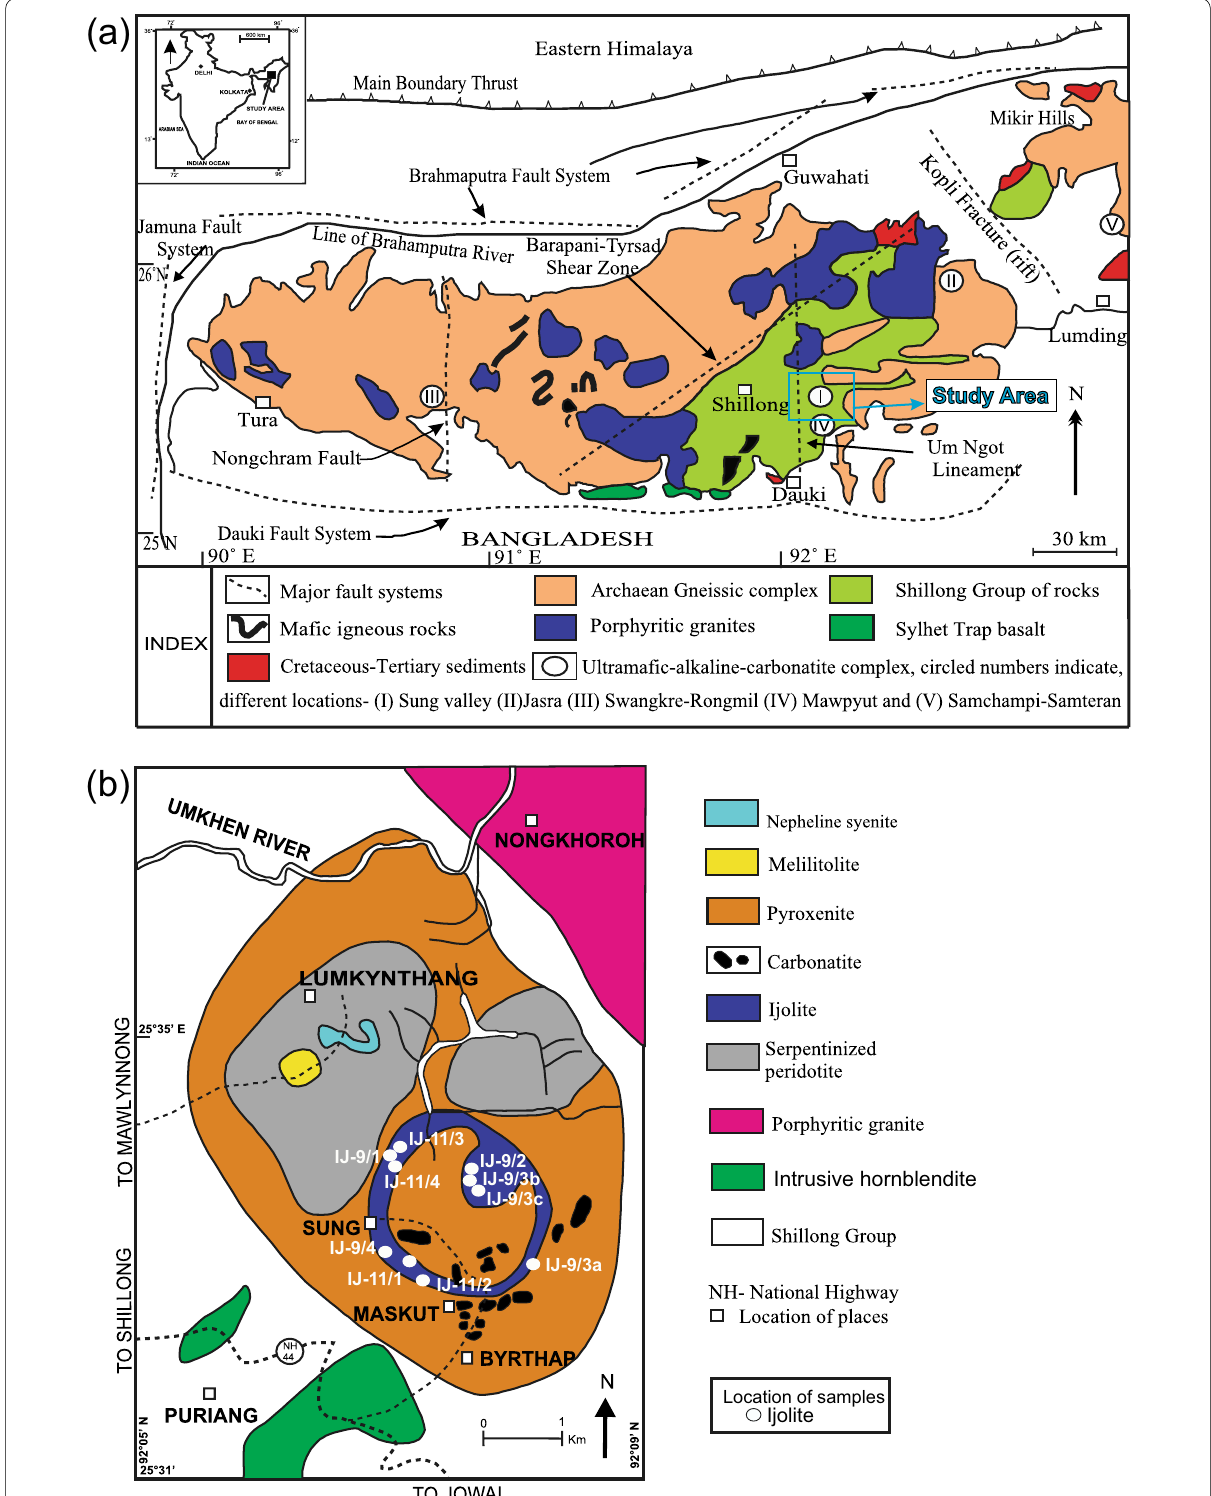
Fig. 1 Geological maps. a Shillong plateau. b Sung Valley, Meghalaya, NE India; highlighted with a square in ( a ). a , b Modified after Srivastava and Sinha